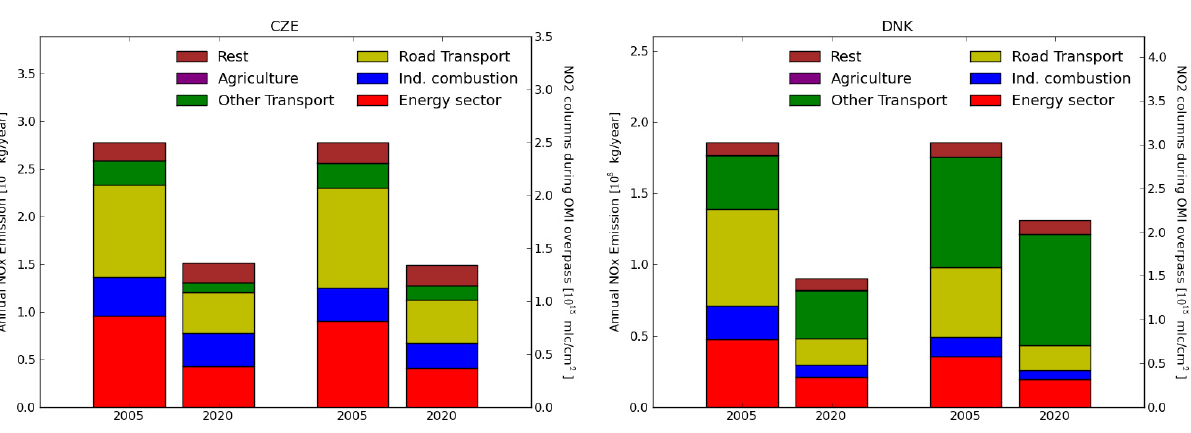
Figure 8. Comparison of emission total, as well as the modeled OMI-NO and 2020 for the Czech Republic (CZE) ( left ) and Denmark (DNK) ( right ). Both the emissions (left two) and modeled (right two) columns are separated into the major